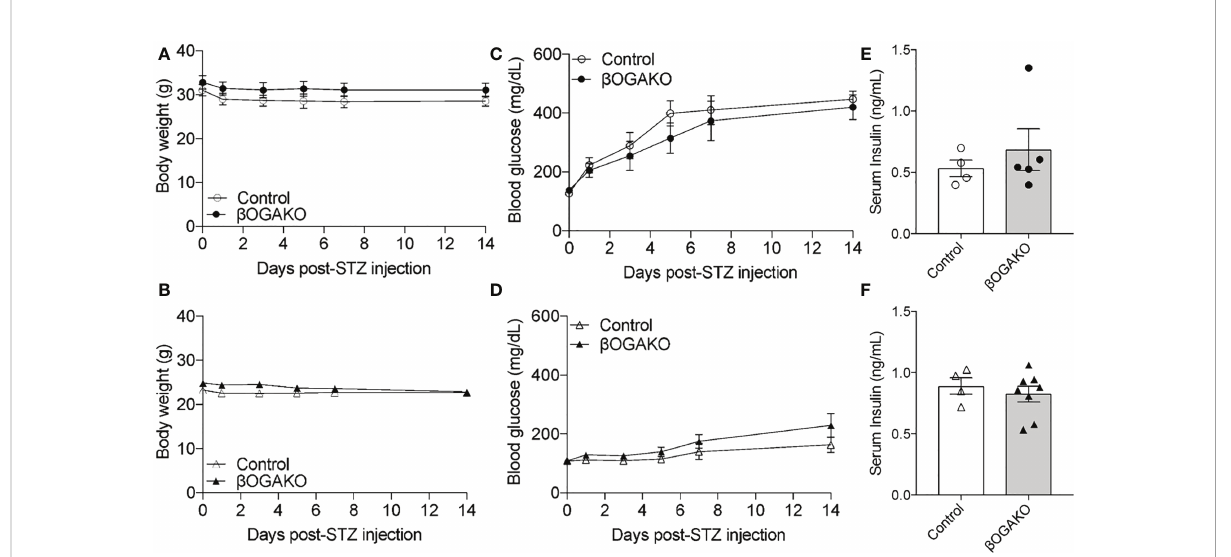
FIGURE 5 Normal response to diabetogenic STZ treatment in b OGAKO mice. Body weight ( A , Male; B , Female) and blood glucose ( C , Male; D , Female) tracked over 2-wks post-STZ injection (n=5-6 for Males, n=5-8 for Females). Serum insulin ( E , Male; F , Female) at 2-wks post-STZ injection (n=4-5 for Males, n=4-8 for Females). Statistical analyses were conducted using two-way ANOVA and unpaired, 2-way student t-test with signi fi cance *p <